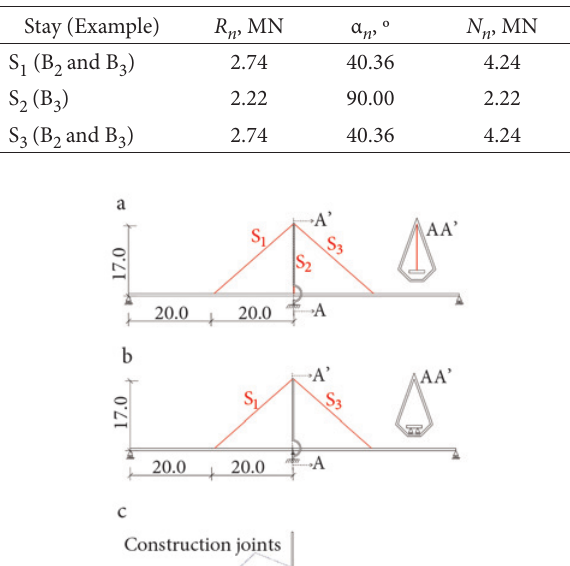
table 1. Parameters of the RCBC of B 2 and B 3